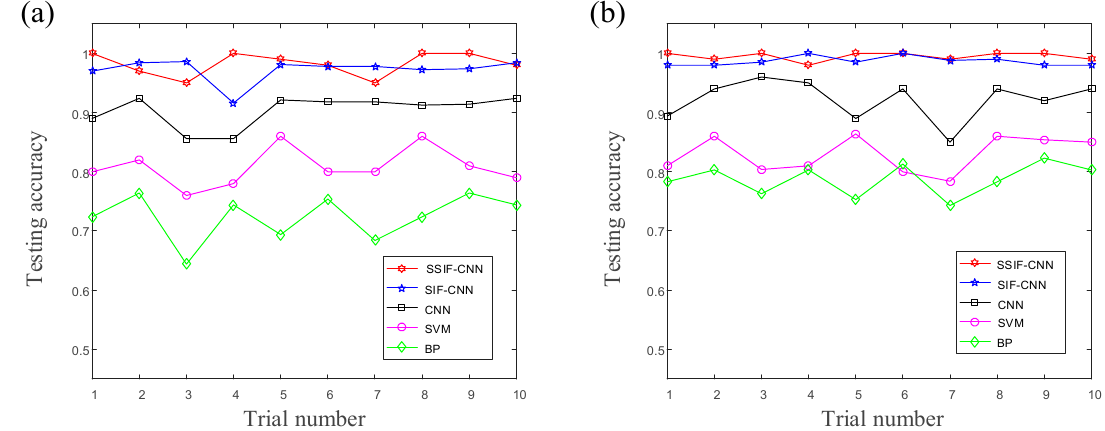
Figure 10. The accuracies of the ten trials: ( a ) training accuracies, and ( b ) testing accuracies. Table 9. Average training time and accuracy of each model. SVM: support vector machine. Model Training Time